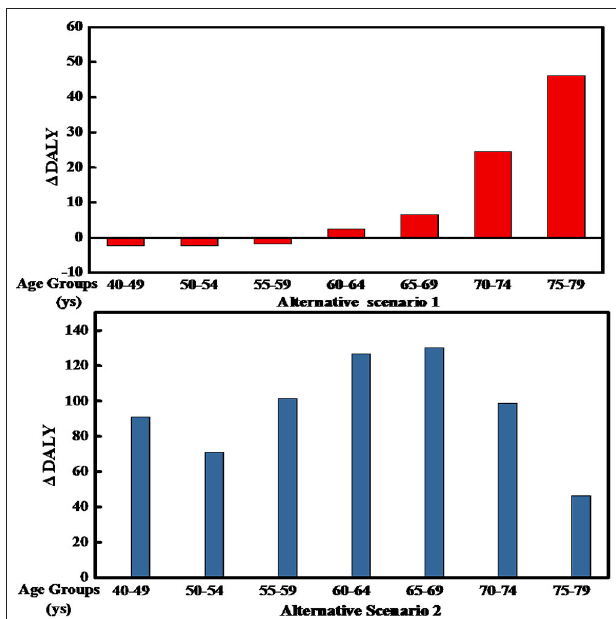
FIGURE 2 | Difference in Disability-Adjusted Life Years (DALYs) for different scenarios and age groups of Chinese men. The bars represent the DALY difference between each group in the two ASs and the current